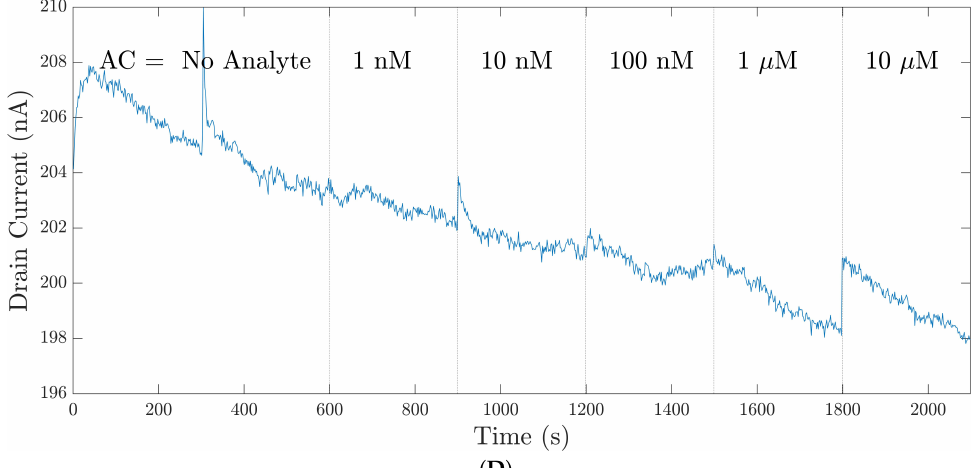
Figure 6. The typical raw signals of the datasets, ( A ) The 35-mer adenosine dataset with an initial concentration of 1 nM, ( B ) the 35-mer adenosine signal with an initial concentration of 1 µ M, ( C ) the 31-mer oestradiol dataset, ( D ) the 35-mer oestradiol dataset. Note that in these plots, AC refers to the analyte